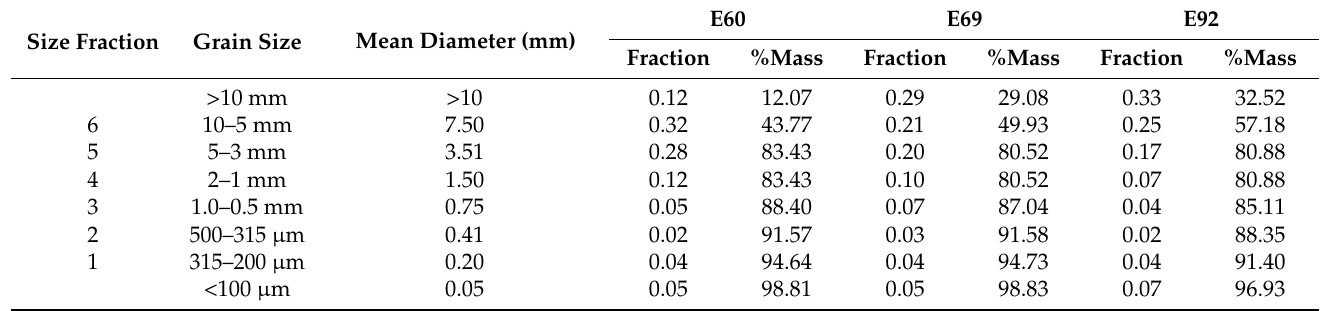
Table 1. Granulometry analysis of selected samples (E60, E69, and E92), showing accumulated percentage mass (% mass) up to this size range and relative mass fraction (fi) (retained mass divided by total